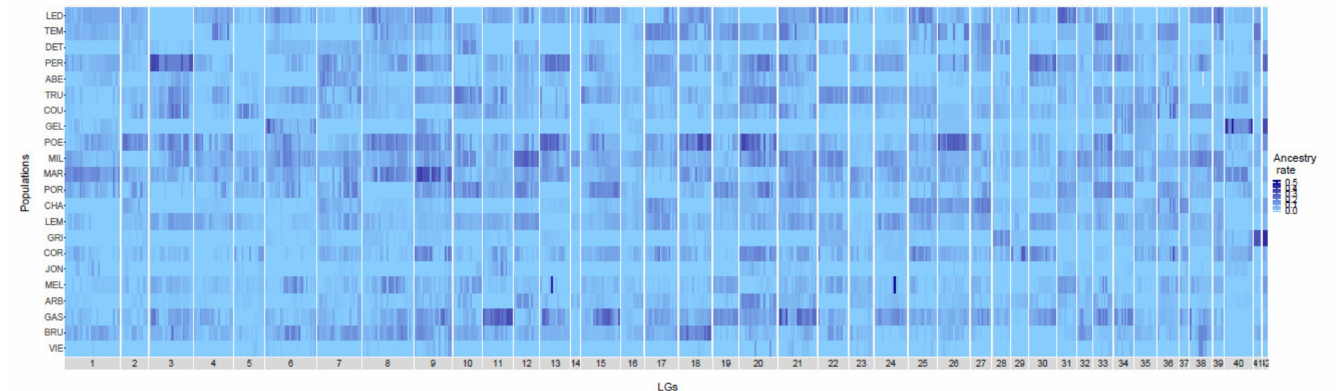
Figure 2. Heatmap of the proportion of domestic ancestry rate along the 42 Brook Charr linkage groups (LGs) for each lake. Lakes are ordered as a function of stocking intensity (less stocked lakes at the bottom). Labels are detailed in Table